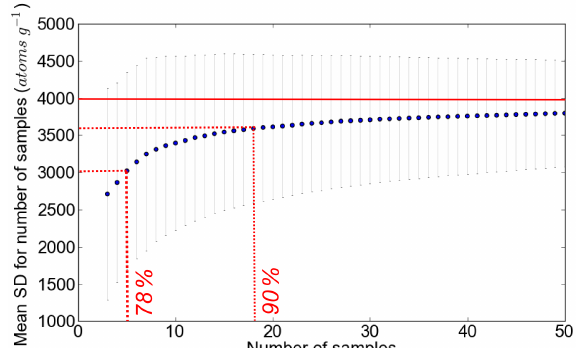
Figure 12. Number of 10 Be samples required to capture the nat- ural concentration variability of the Ganga River. Approximately 18 samples are required to be within 10% of the true standard de- viation (or variability) of the system. Blue dots represent the mean standard deviation of 100 populations of concentrations for a given sample group size (between 3 and 50). Error bars represent the stan- dard deviation of the mean standard deviation of those 100 popula- tions per sample group size. The solid horizontal red line represents the mean standard deviation value that the sample group sizes con- verge towards (4000atomsg − 1 ). The two dashed red lines represent the number of samples required to be within 10% of the true stan- dard deviation (labelled 90%) and the standard deviation expected from a set of five samples (labelled